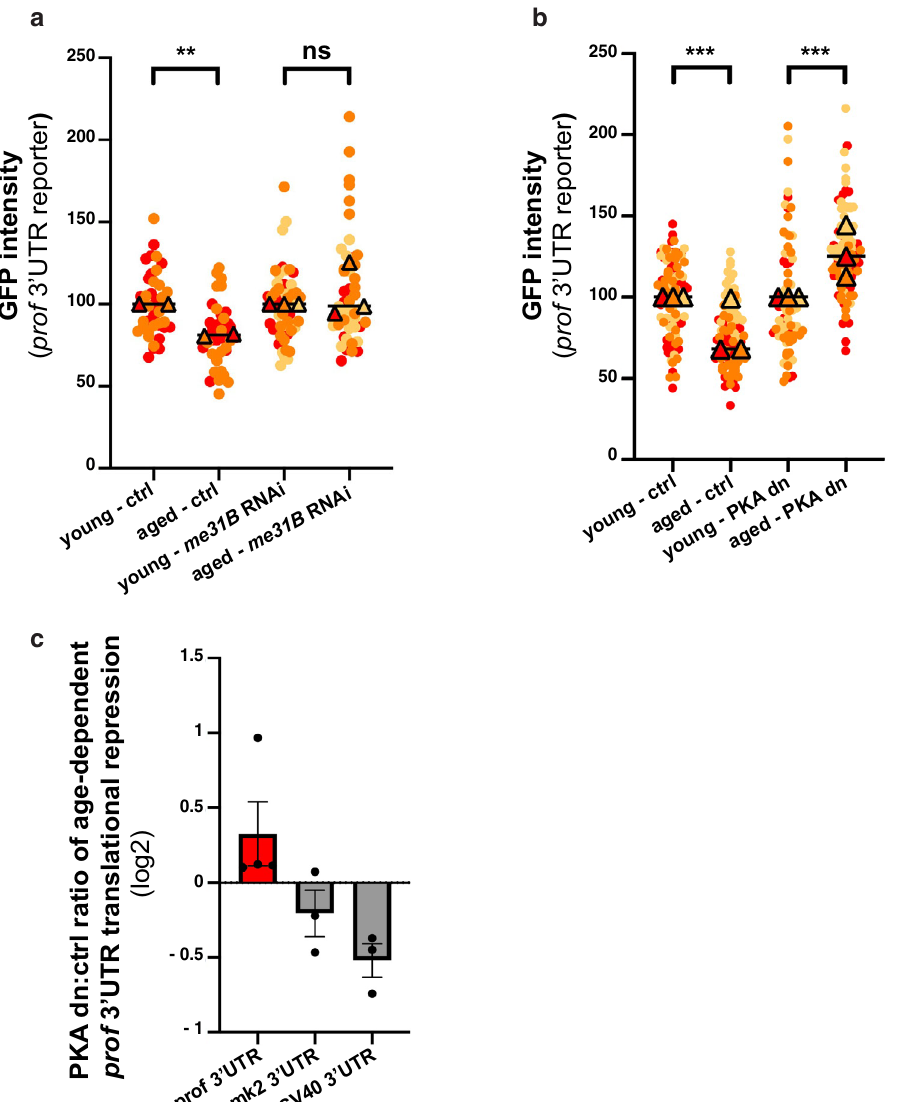
Fig. 9b. Error bars represent s.e.m. Source data are provided as a Source Data fi